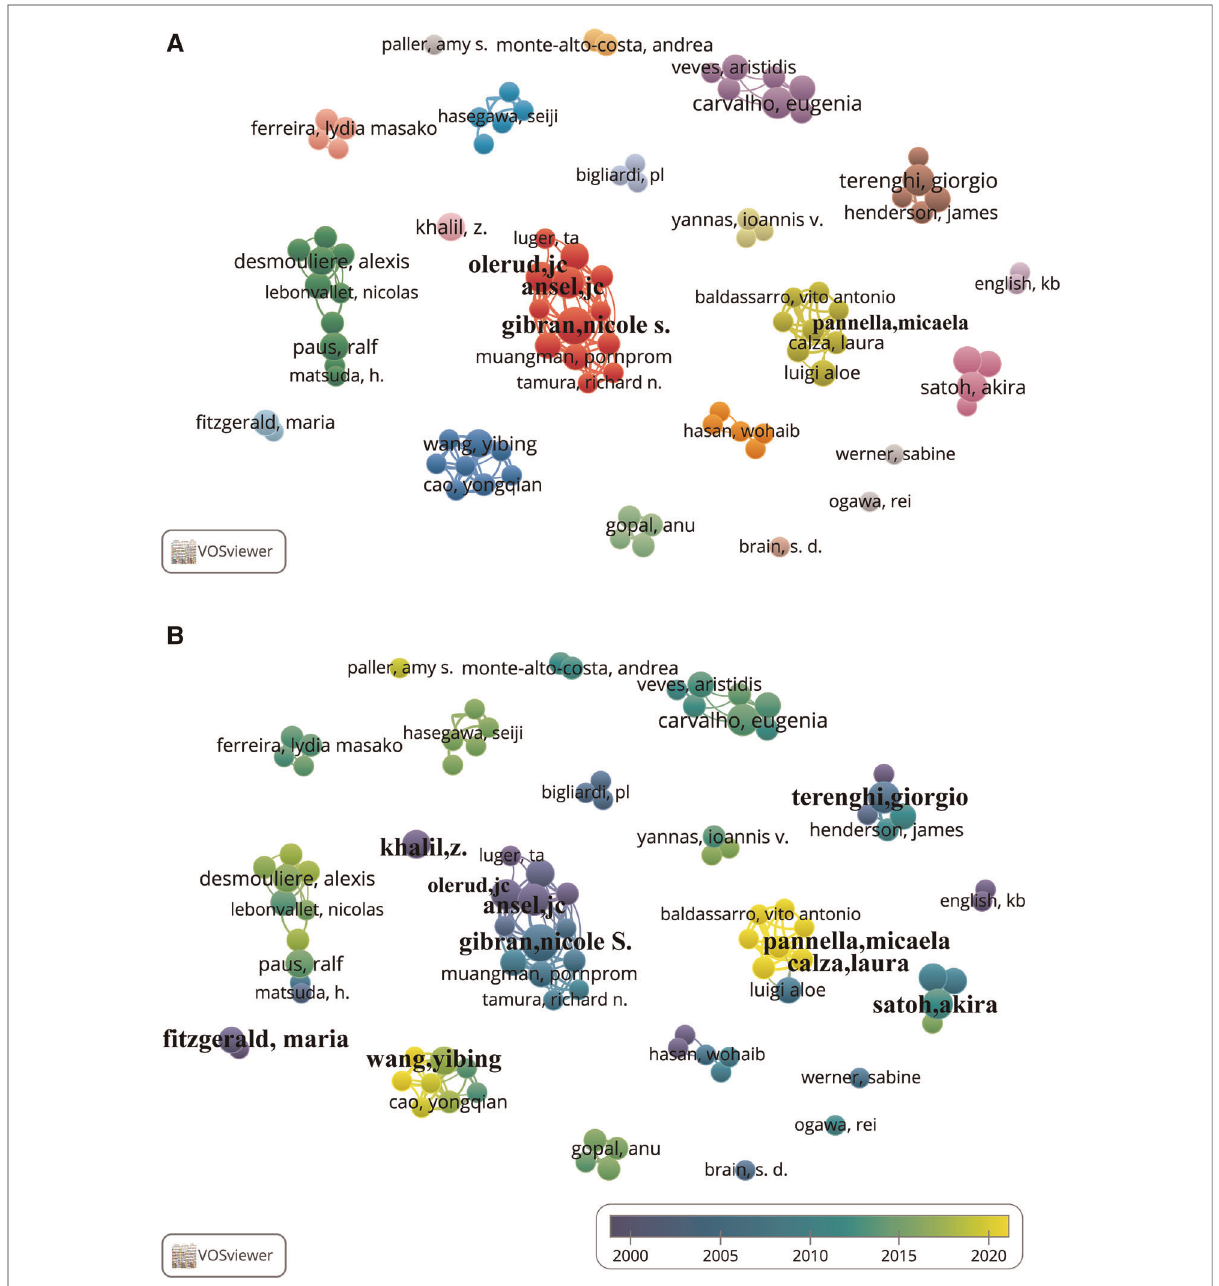
FIGURE 7 Author co-authorship networks. Each node represents an author, and each line represents a link between two authors. The size of each node represents the number of documents of each author, and the thickness of each line represents the strength of the link. ( A ) Co-authorship network map of the 90 authors with at least three documents. The colour of each node in ( A ) represents the clusters of each author. ( B ) Author co-authorship time-overlay map of the co-authorship networks of the 90 authors with at least three documents. The colour of each node represents the average publication year, according to the colour gradient presented in the lower right